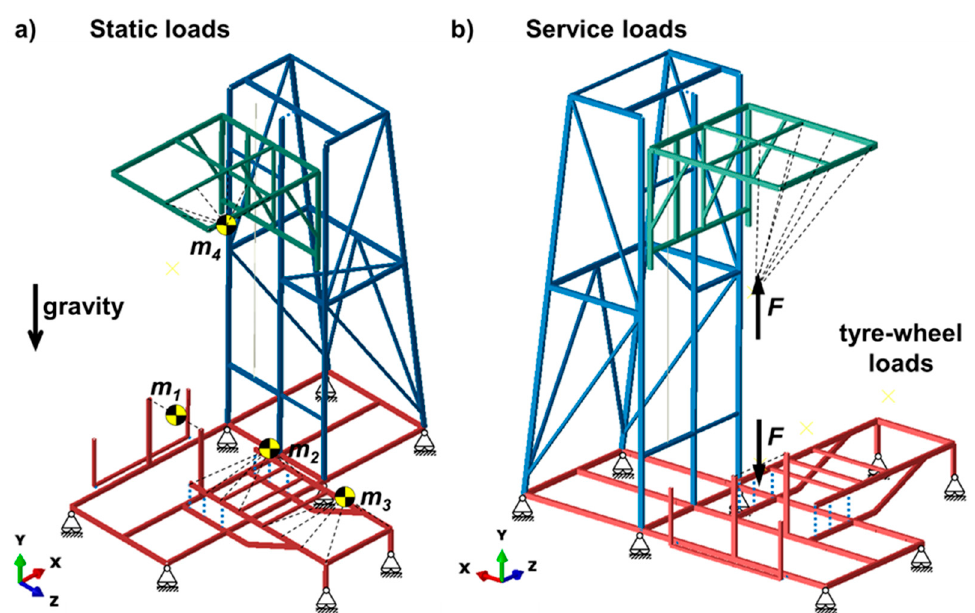
Figure 3. 1D model highlighting all boundary conditions for ( a ) static and ( b ) service conditions; 1D elements shown through a 3D rendering with a scale factor of 0.2 to improve visibility.